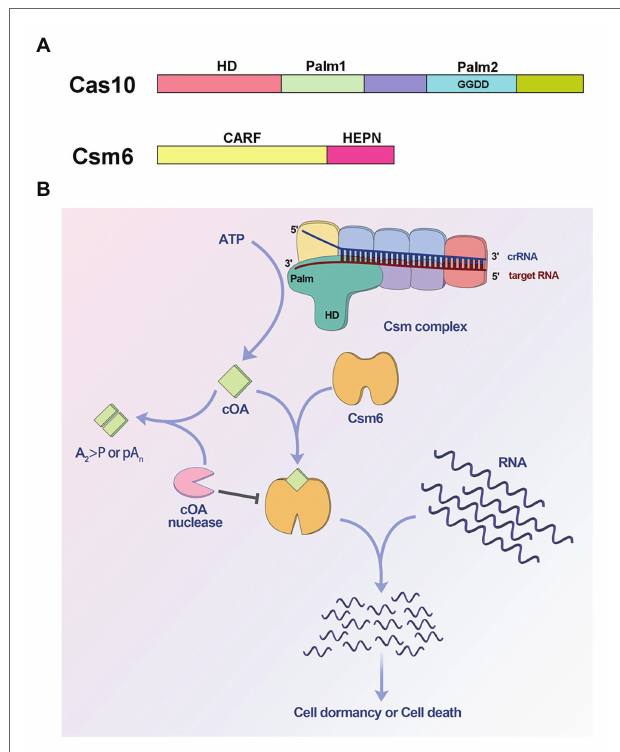
FIGURE 1 | Cyclic oligoadenylate (cOA) signaling-mediated immunity in type III CRISPR-Cas systems. (A) Domain organization of Cas10 and Csm6. Cas10 contains an N-terminal histidine-aspartate (HD) domain and two Palm domains (Palm1 and Palm2), and the GGDD motif is inserted into Palm2 domain. Csm6 contains an N-terminal CRISPR-associated Rossman fold (CARF) domain and a C-terminal higher eukaryotes and prokaryotes nucleotide-binding (HEPN) domain. (B) Model for cOA signaling pathway of type III systems. The Palm domains of Cas10 subunit are activated and convert ATP into cOA molecules, when the target RNA is recognized by the CRISPR RNA (crRNA)-guided effector complex. The synthesized cOA allosterically activates Csm6 by binding the CARF domain, which subsequently degrades RNA non-specifically, resulting in host cell dormancy or cell death. On the other hand, cOA nucleases including ring nuclease and membrane-associated DHH-DHHA1 family nuclease can degrade cOA molecules to switch off cOA signaling, thereby acting as off-switch for the